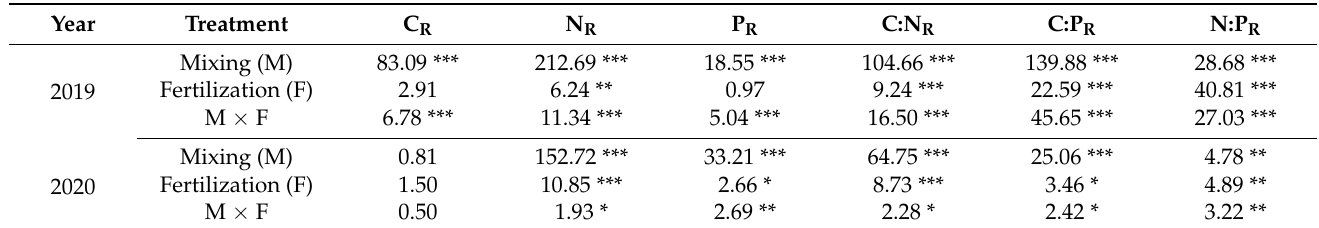
Table 3. Effects ( F value) of mixing, fertilization, and their interaction on root C, N, and P concentra- tions and stoichiometric